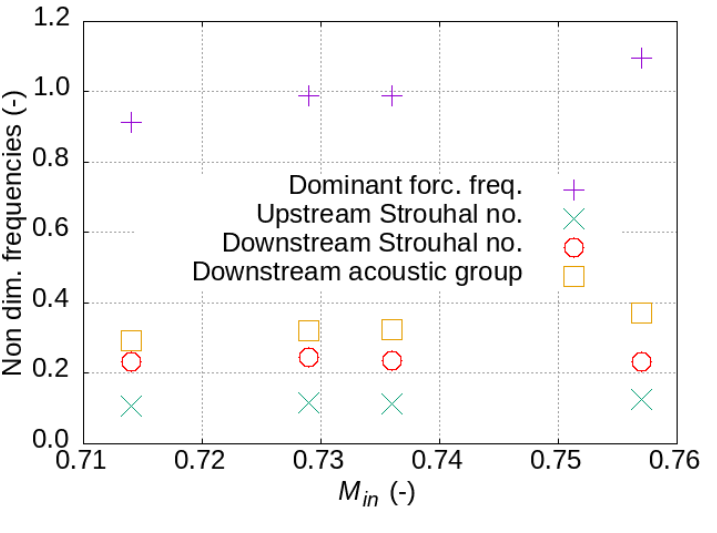
Figure 9. Parametric sweep of M in , comparing dominant forcing frequency, acoustic frequency and St at different locations.